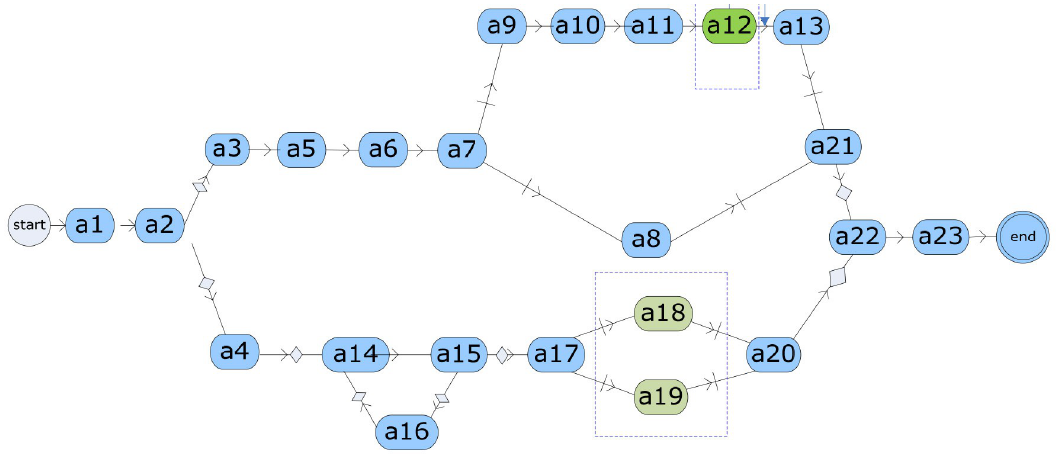
Figure 3. Compound workflow process